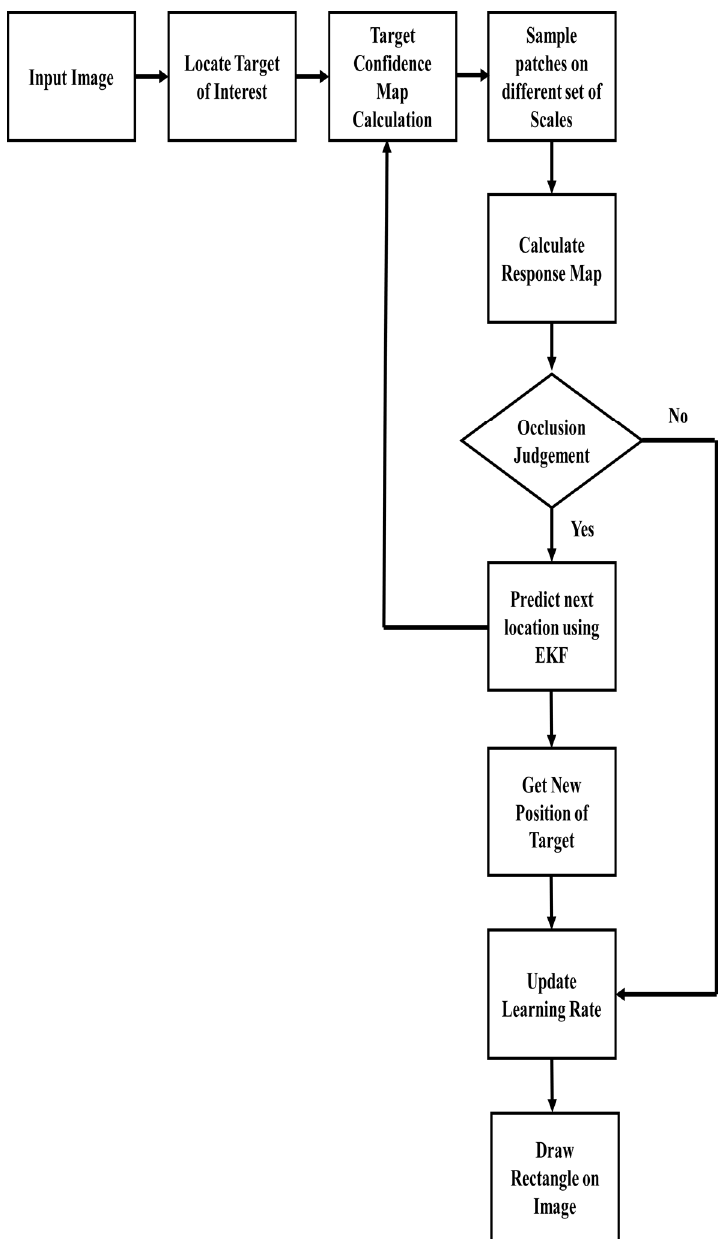
Figure 2. Flowchart of the proposed tracking model.